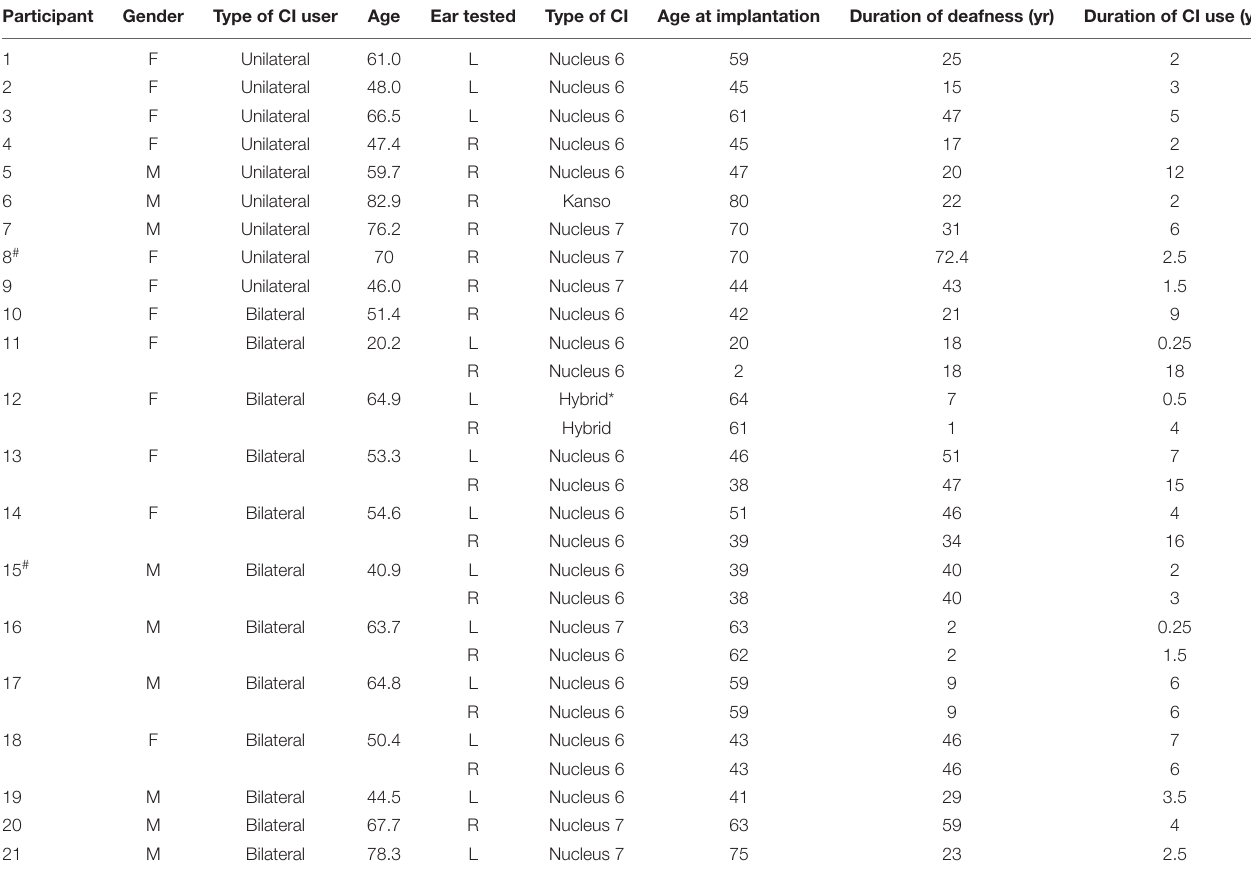
TABLE 1 | Cochlear implant (CI) users’